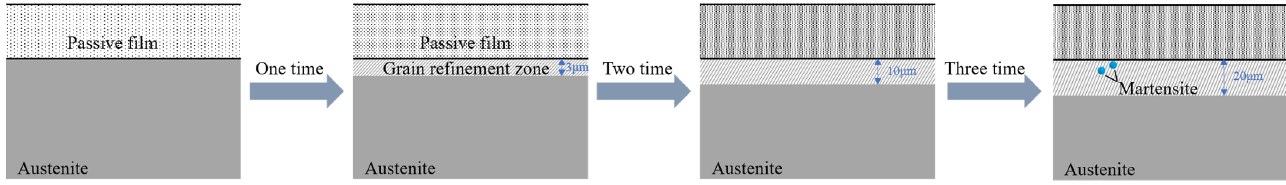
Figure 12. Schematic diagram of laser shock treatment applied to the welded area of the 316L stain- less steel samples.